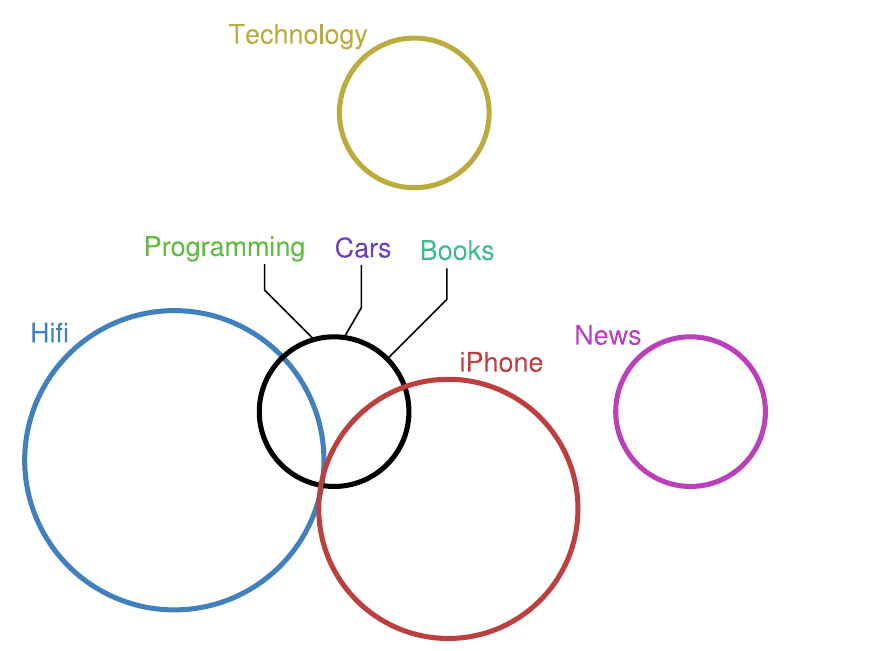
Fig 4. Concurrent curves are depicted in